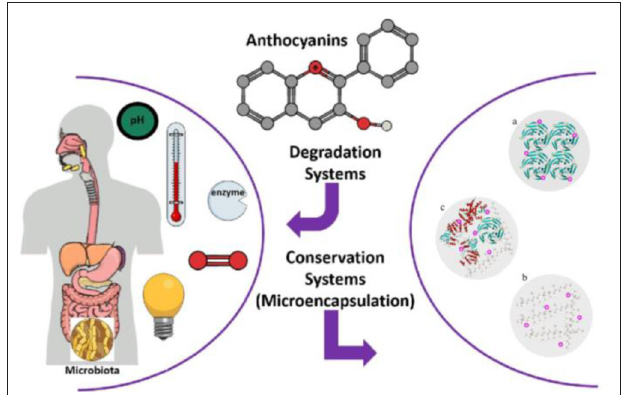
FIGURE 2 | Schematics of anthocyanin degradation and biopolymer-based microencapsulation systems (a-protein particles, b-polysaccharide particles, and c-protein plus polysaccharide particles). Reprinted or adapted from references (12, 32–34) with